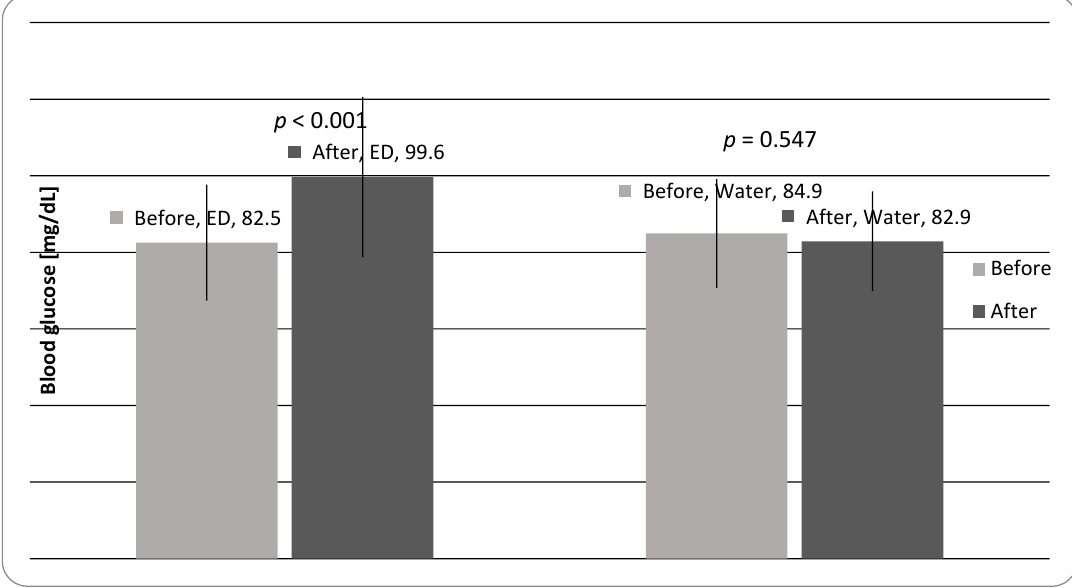
Figure 3. Values of blood sugar (mean) in the study participants before and after 3 EDs/water consumption. Table 4. Symptoms reported by the research participants during the consumption of EDs *. Symptoms (Discomforts) after 1 ED after 2 ED